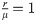
Estimated demographic history with selfing.Estimated demographic history using four simulated sequences of 10 Mb and ten replicates under a saw-tooth demographic scenario (black). The mutation and recombination rates are set to 2.5 × 10−8 per generation per bp, and simulations were run for four different self-fertilization rates (σ = 0 (red), 0.5 (blue), 0.8 (green) and 0.9 (purple)), and as rμ=1, this gives ρθ=1, 0.5,0.2 and 0.1 respectively. The demographic history is estimated using a) eSMC, b) MSMC, c) MSMC2 and d) PSMC’. σ* represents the self-fertilization rate estimated by eSMC.